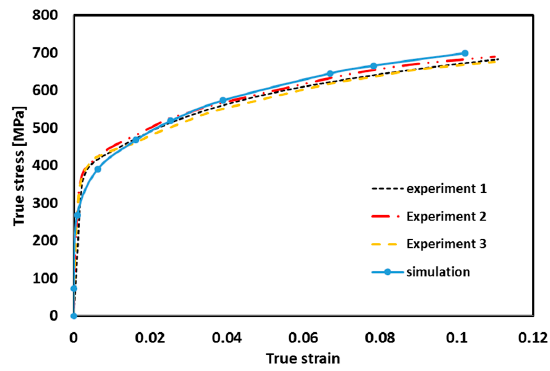
Figure 6. Flow curve of the investigated dual phase (DP) steels (Experiment and Simulation).